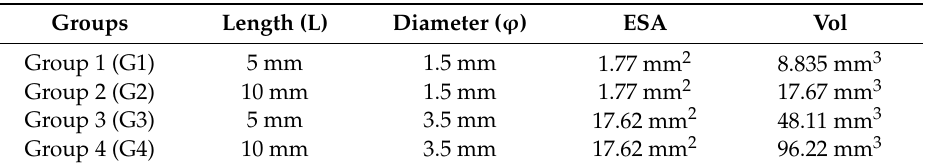
Table 6. Outline of the four groups with different ESA and